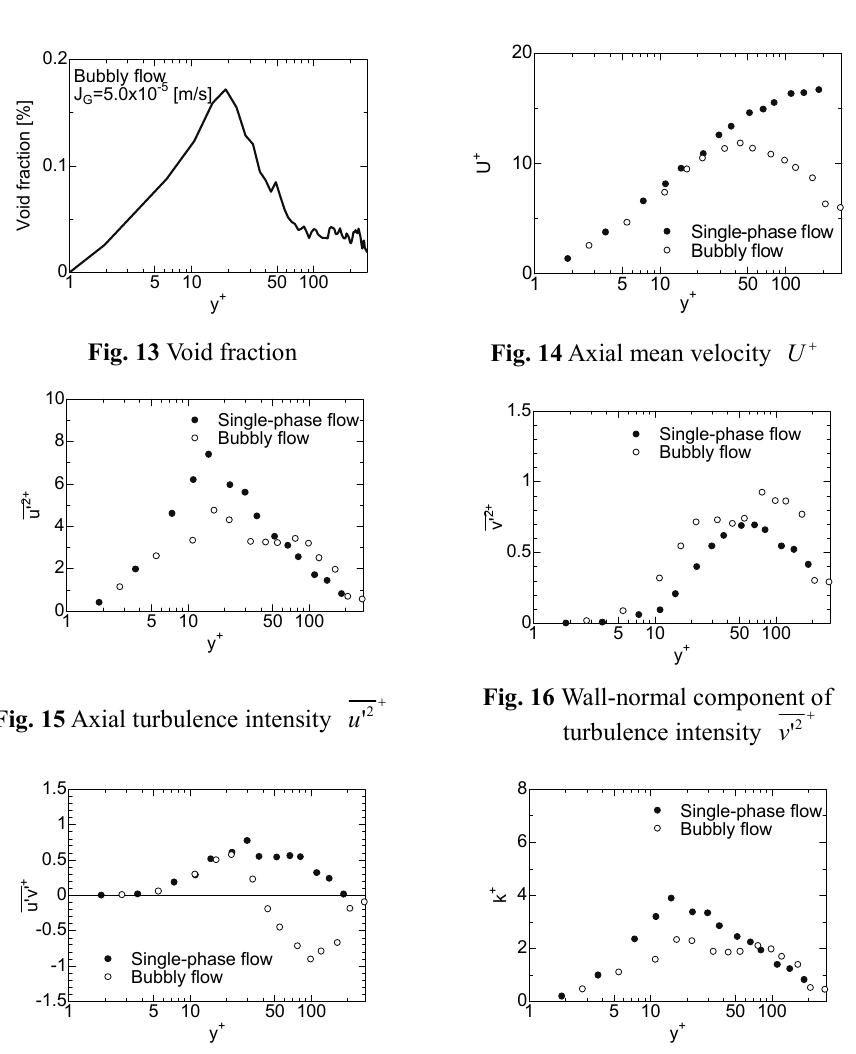
Fig. 17 Reynolds shear stress Fig. 18 Turbulence kinetic